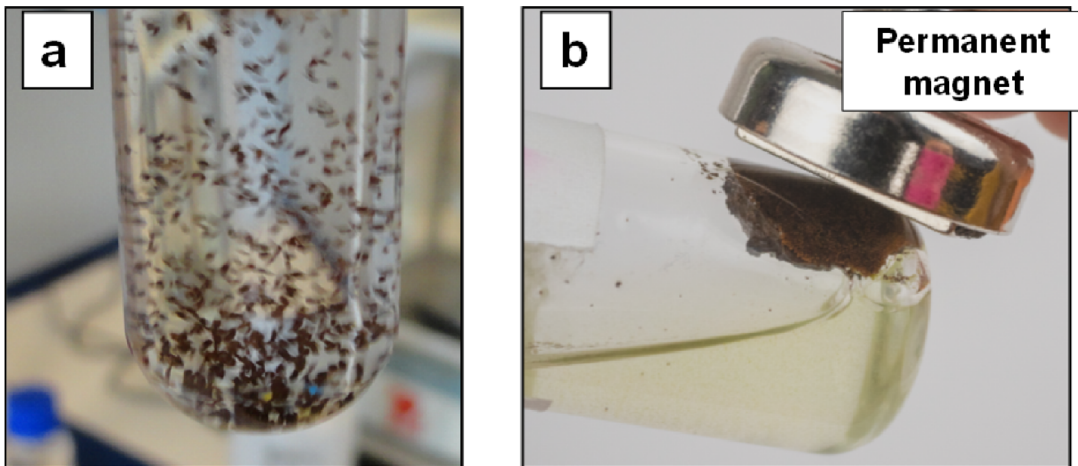
Figure 15. ( a,b ) Dispersion of PLA − magnetite nanocomposites (microparticles) in PBS ( a ) Figure 15. ( a , b ) Dispersion of PLA − magnetite nanocomposites (microparticles) in PBS ( a ) and illustration of magnetic and illustration of magnetic separation ( b ). separation ( b